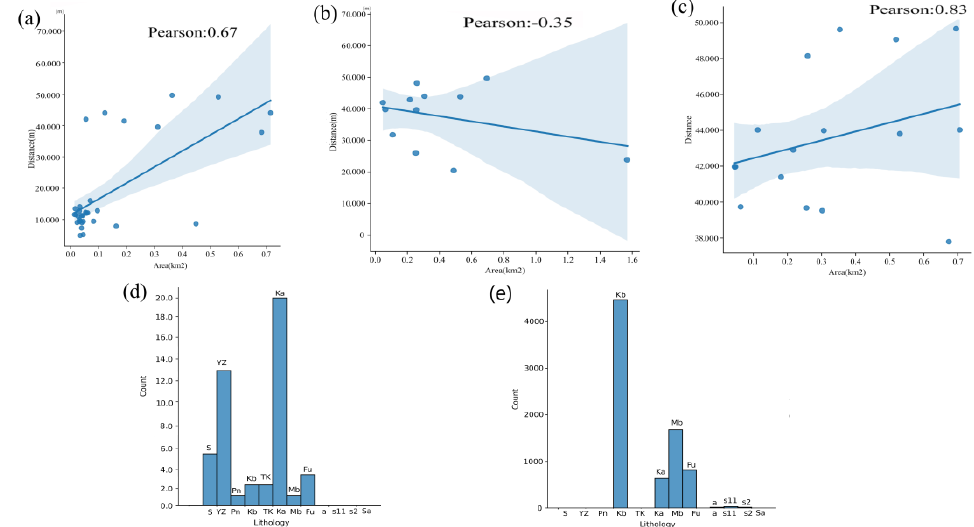
Figure 16. ( a ) The link between the landslide area and the epicentral distance after the earthquake. ( b ) The link between the landslide area and the epicentral distance before the earthquake. ( c ) The link between landslide area and epicenter distance in the far-field region. ( d ) The lithological distribution of slow-moving landslides. ( e ) The lithological distribution of co-seismic landslides, using information from the GSI.